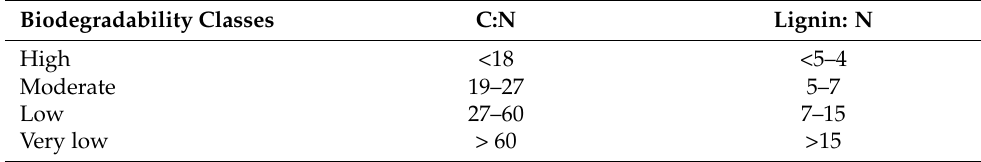
Table 5. The classes of fresh organic matter susceptibility to biodegradation (Kumar et al. [109]). Biodegradability Classes